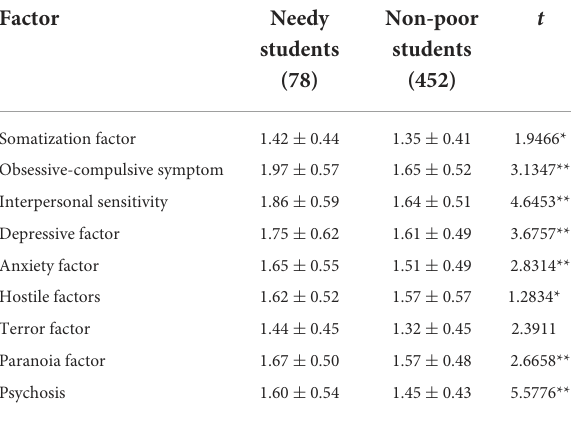
TABLE 2 Results of SCL-90 factors for poor and non-poor students.